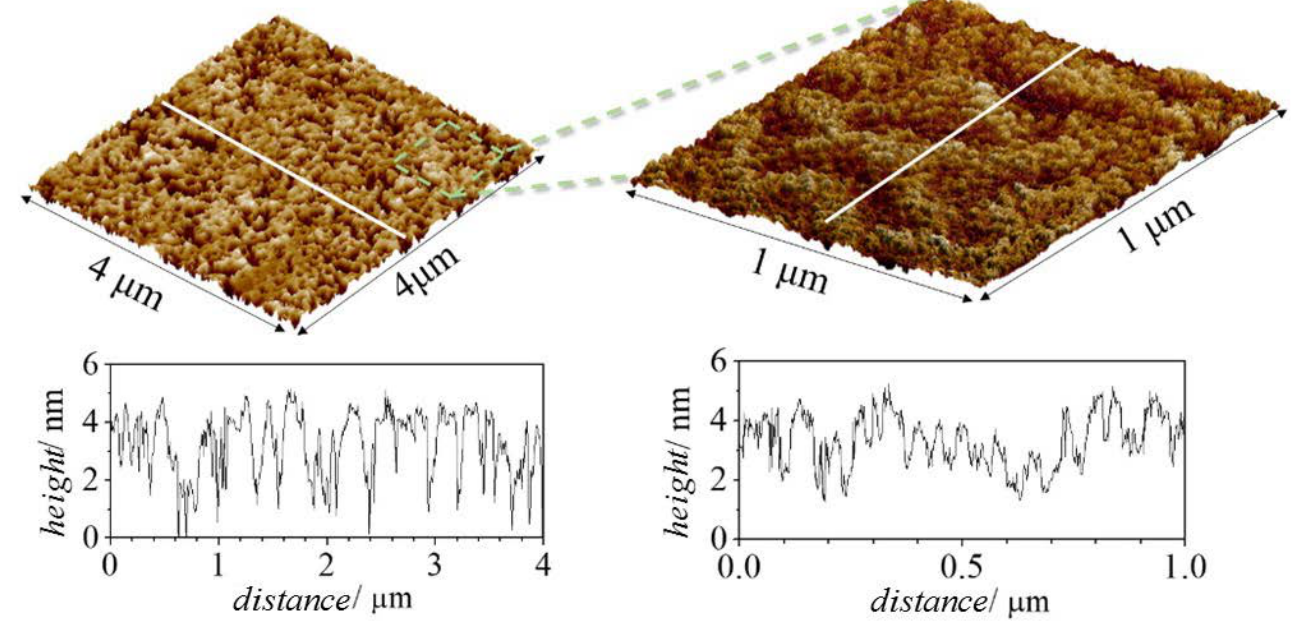
Figure 8. Experimental results obtained by AFM for a layer adsorbed from the concentrated Merquat 2003–CAPB solution of df = 1. Three-dimensional topographic images obtained over an area of 4 × 4 μm 2 using a scanning resolution of 15.6 nm/pt ( left image), and over an area of 1 × 1 μm 2 using a scanning resolution of 3.9 nm/pt ( right image). Below each image is depicted the corresponding height profile performed along the white line.